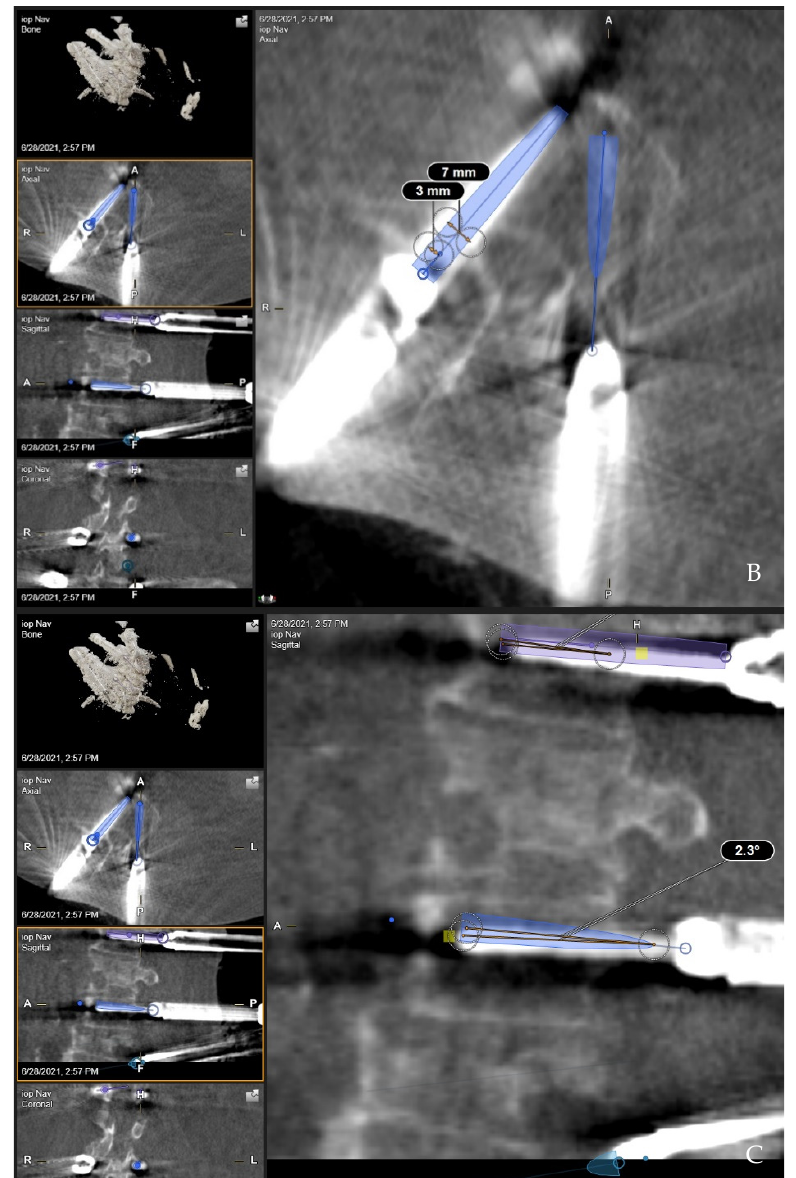
Figure 7. Accuracy of the implanted pedicle screws and deviation compared to the preoperatively planned screw trajectories were measured using the image overlay technique following rigid and elastic fusion of the preoperative CT scan, registration iCT scan and control iCT scan. ( A ). Implanted screws are segmented in red and the trajectory of the preplanned screws in blue. Entry point and tip point deviation were measured in the axial plane. ( B ). Overlay of a preplanned screw trajectory with the implanted pedicle screw. Entry point deviation 3 mm to medial and lateral from the entry point of the preplanned screw trajectory was considered acceptable for correct pedicle screw placement. ( C ). Angular deviation was measured in the lateral plane via the angular measurement tool in the BrainLab software using the measurement of the angle between the axis of the implanted screw and the preplanned screw